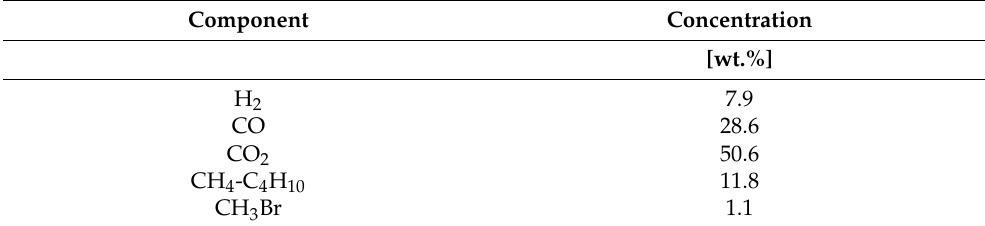
Table 15. Chemical composition of the gas phase.